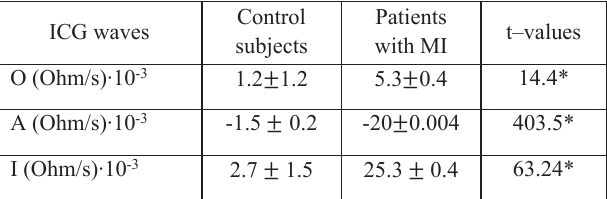
Table 2. ICG wave amplitudes for control subjects and